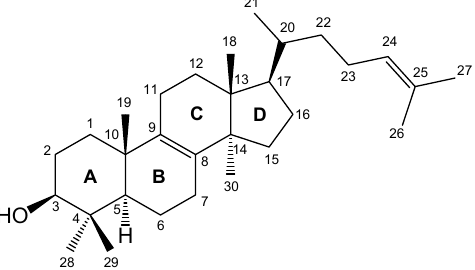
Figure 1. The structure, stereochemistry and numbering of lanosterol.